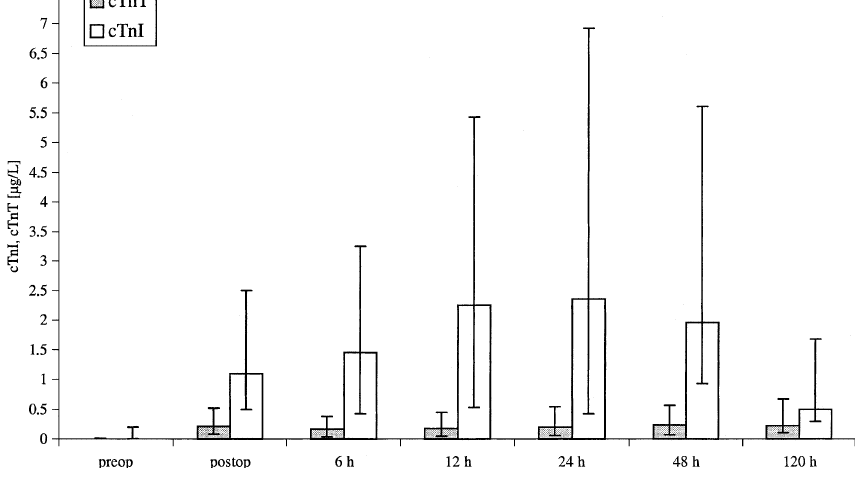
Postoperative median cTnI and cTnT serum concen- tration time courses. Vertical lines indicate 25%-quartile (Q1, in- ferior end of the line) and 75%-quartile (Q3, upper end of the line) of the